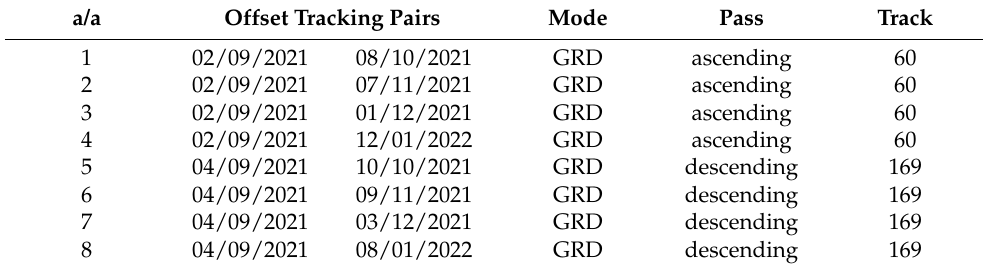
Table 3. Parameters of Sentinel-1 pairs, as processed using offset tracking (acquisition dates, product type and orbital